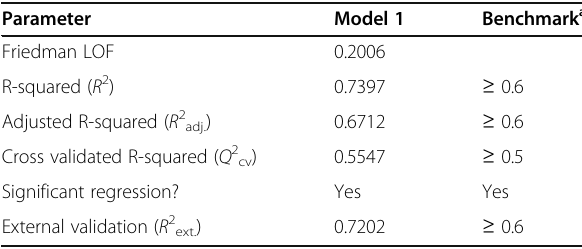
Table 2 Model validation parameters